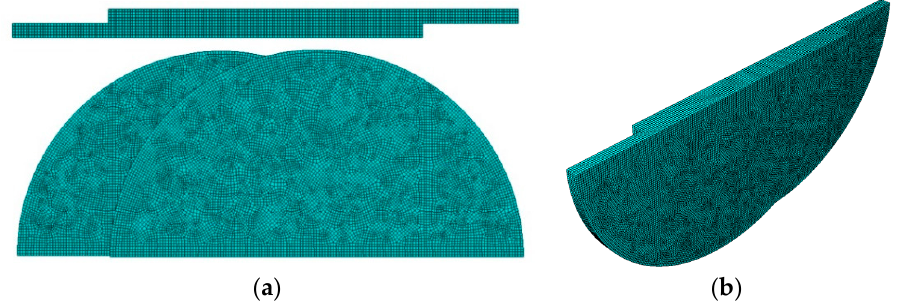
Figure 11. Finite element mesh: ( a ) Top view and joint view showing a well-structured mesh with 0.2 mm hexahedral elements in the joint; ( b ) Isometric view.